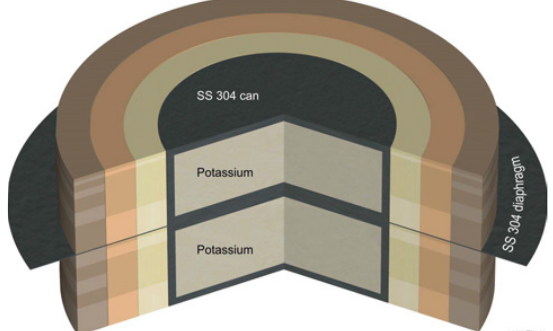
Figure 6. Oralloy metal annuli with potassium-filled steel